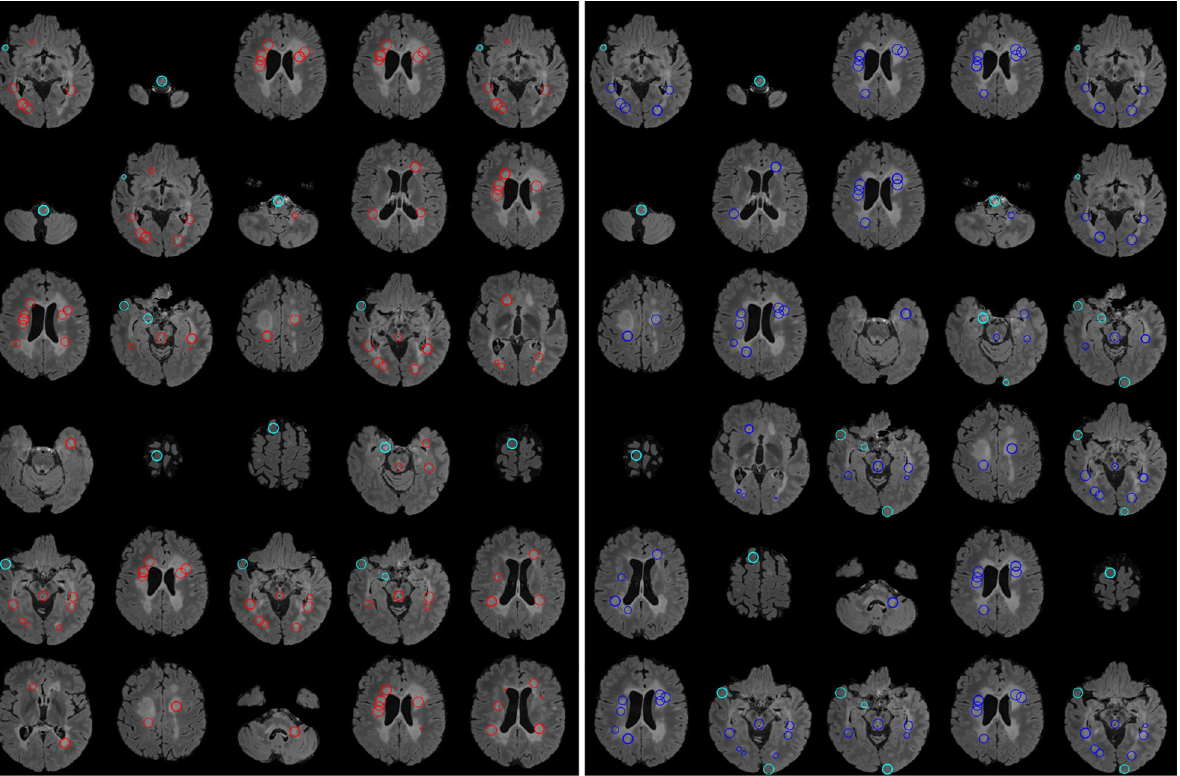
Figure 5. The top 30 detected lesions resulting from the O ( a max N ) - (left) and FFT-based (right) template matching algorithms on the first case of MSSEG 2016 training data. The red ( O ( a max N ) ) and blue (FFT) circles indicate the true lesions, and the false lesions are identified with cyan colored circles. Thick lesions are those centered at the shown slice, whereas thin circles represent the intersections with other detected spheres in the nearby slices. The performance of the two methods are similar, given that they both exhaustively search for the lesion size that maximizes the same NCCC, albeit computed with different algorithms. However, as seen in Fig. 3, these two methods do not achieve the accuracy of the O ( N )